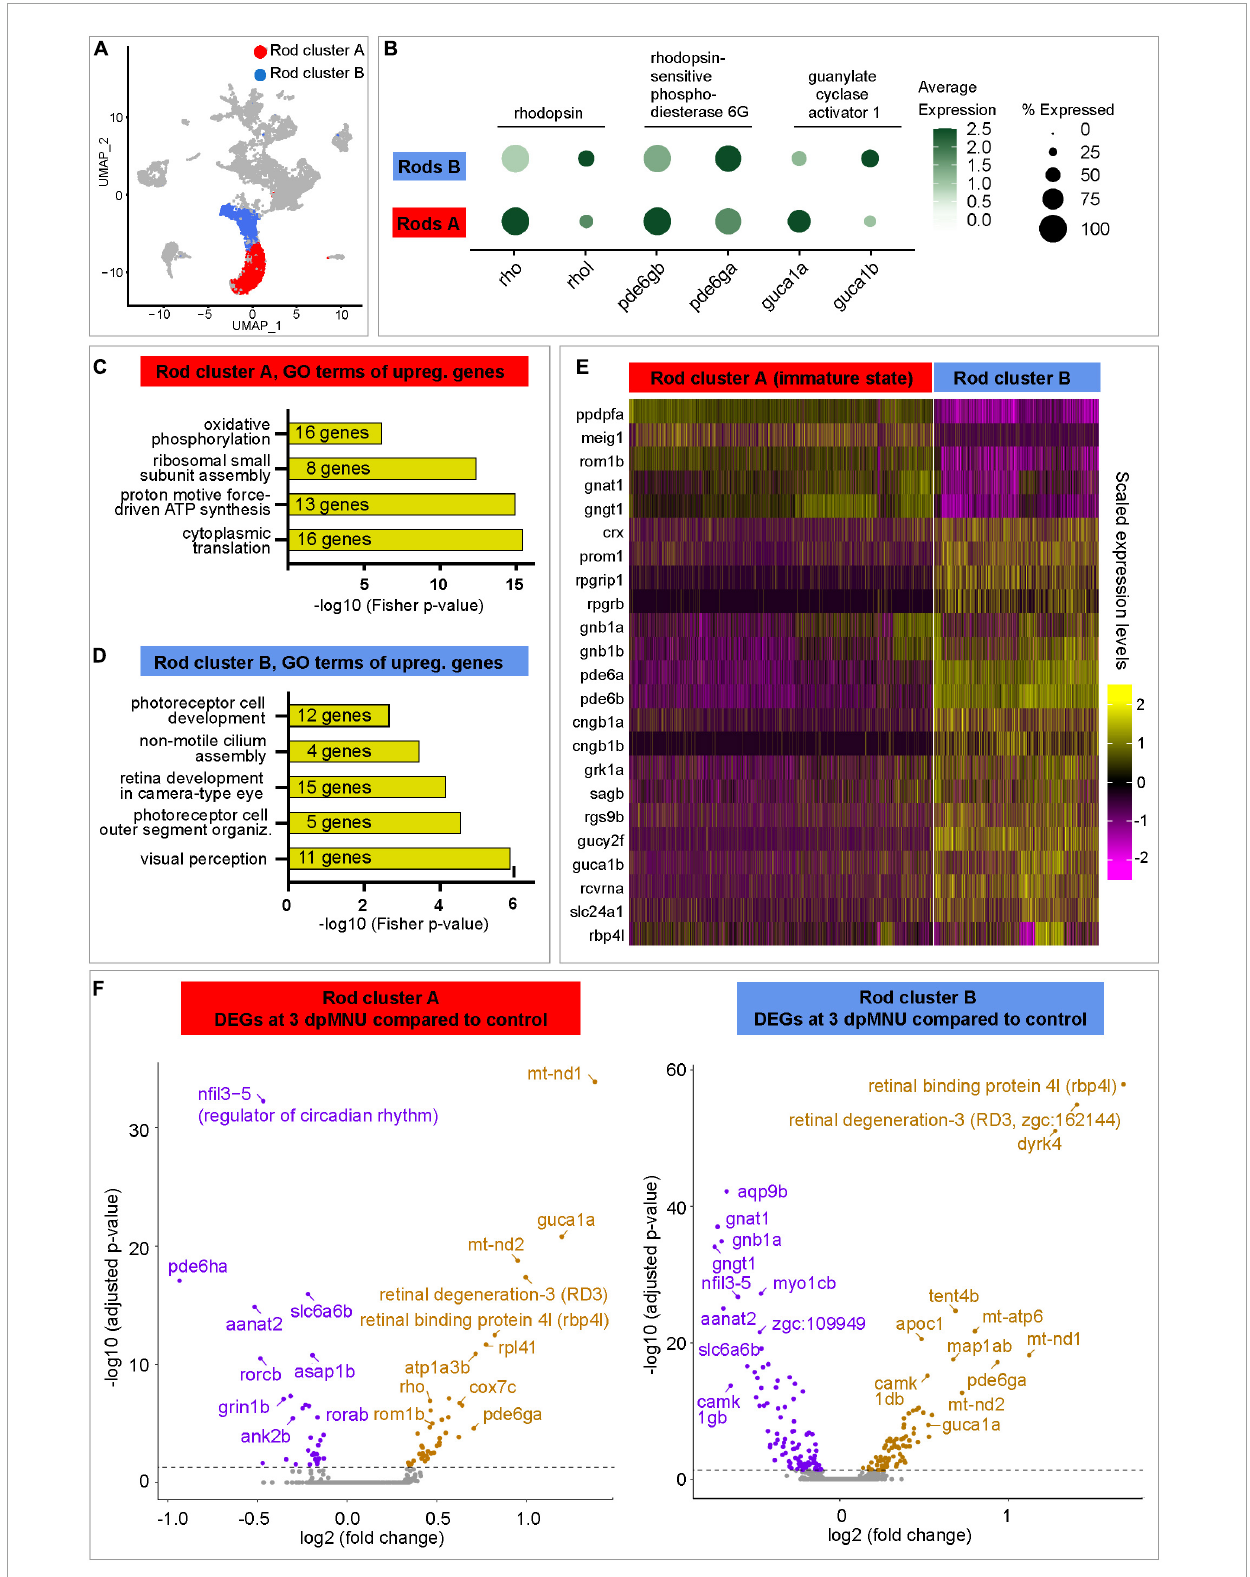
FIGURE6 Transcriptome dynamics of immature and mature rods following MNU chemical injury. (A) UMAP plot of merged datasets showing the rod clusters in color and other cell clusters in gray. (B) Dot plot displaying differential expression levels of three pairs of paralogous genes of the rod identity in cluster A and B. (C,D) Selected Gene Ontology terms of upregulated genes in each rod cluster. Complete data are in Supplementary Table 4 . (E) Heatmap of selected genes that display differential expression between both rod clusters. Complete data are in Supplementary Table 4 . (F) Volcano plots of DEGs within each of rod clusters between 3 dpMNU compared to uninjured control. Complete data are in Supplementary Tables 5 , 6